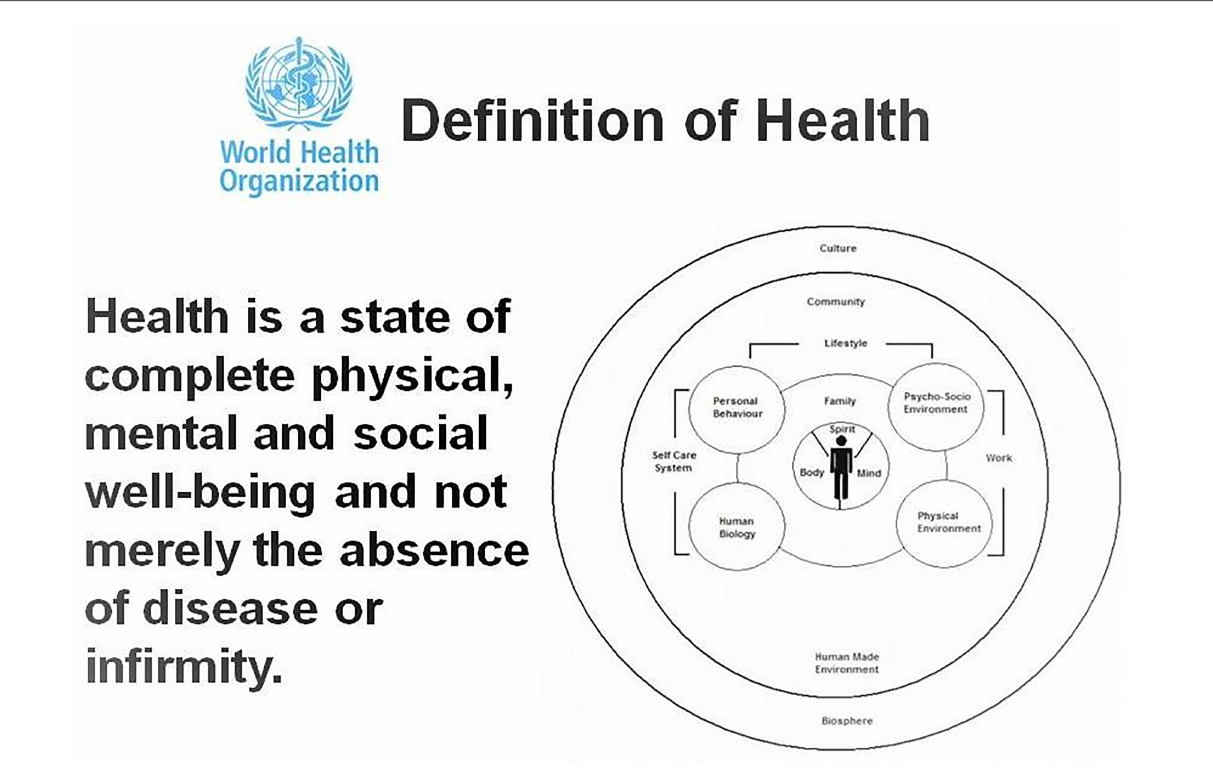
FIGURE 1 WHO de fi nition of health. https://www.publichealth.com.ng/wp-content/uploads/2019/08/who-de fi